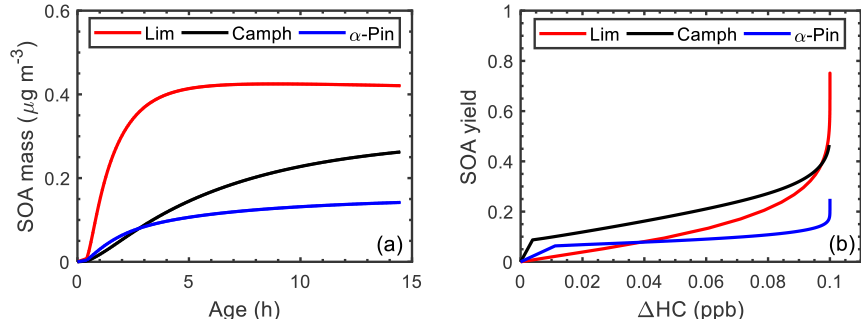
Figure 9. (a) Simulated SOA mass as a function of atmospheric aging time (reaction with OH) and (b) simulated SOA yield as a function of reacted hydrocarbon concentration ( (cid:49) HC) during the controlled reactivity simulation at 0.1ppb HC o with 10µgm − 3 seed for limonene (red line), camphene (black line), and α -pinene (blue